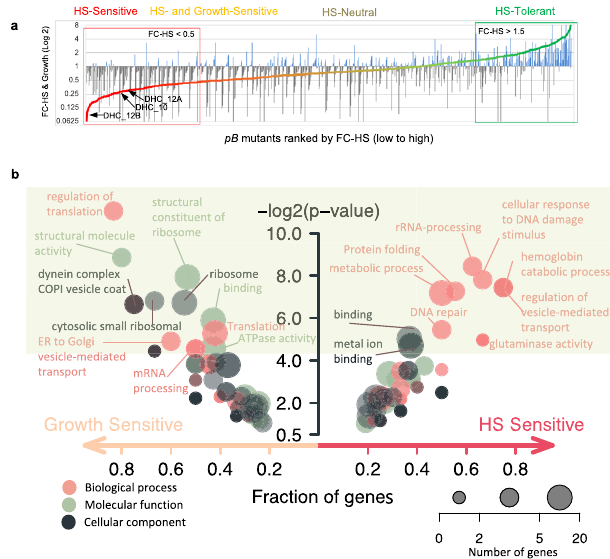
Fig. 2 Large-scale pooled phenotypic screens enable identi fi cation of processes underlying the P. falciparum heat-shock response. a HS- Sensitive mutations identi fi ed in pooled screens of the 1K-library of pB - mutants (Supplementary Data File 2). The uncloned, large mixed- population pools comprising the 1K-library ( n = 12) were parallelly screened in both ideal growth conditions and under HS. Mutants were assigned phenotypes as per methods established in the pilot-library screens (Fig. 1 and Supplementary Data File 2). Mutants are ranked by fold-change from HS-Sensitive (red; n = 149, FC-HS < 0.5 and PFS HS < 0.25) to HS-Tolerant (green; n = 139, FC-HS > 1.5). Mean mutant fold-change in ideal growth (FC-Growth) is superimposed as a bar plot (gray, FC-Growth <1.0; blue, FC- Growth > 1.0). Mutants performing poorly in both screens (yellow; n = 91, FC-HS < 0.5, PFS HS > 0.25) were classi fi ed as HS- and Growth-Sensitive and were not considered further (Supplementary Fig. 9). Mutations neither HS-Sensitive nor HS-Tolerant were classi fi ed as HS-Neutral (taupe, n = 543). Internal redundancy within the 1K- and pilot clone libraries allowed assessment of correlation between identical or same-gene mutants across pools. Phenotypes were highly reproducible. See Supplementary Figs. 6a – c,